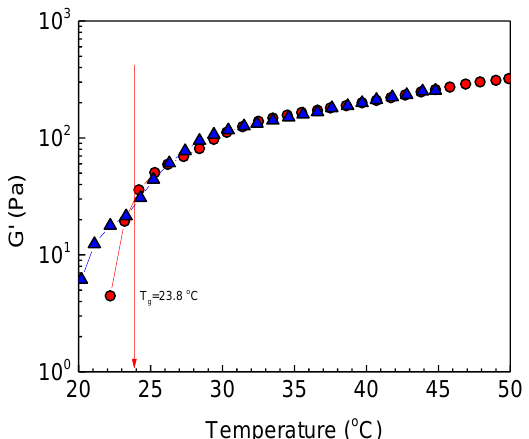
Figure 6. G’ versus temperature of ALG-g-P(NIPAM 86 - co -NtBAM 14 ) (triangles) and ALG/HGC (circles). The values of the latter have been shifted in the X axis (T-ΔΤ, ΔΤ = 5.1 °C is the difference between the two T gels ). The arrow indicates T gel.